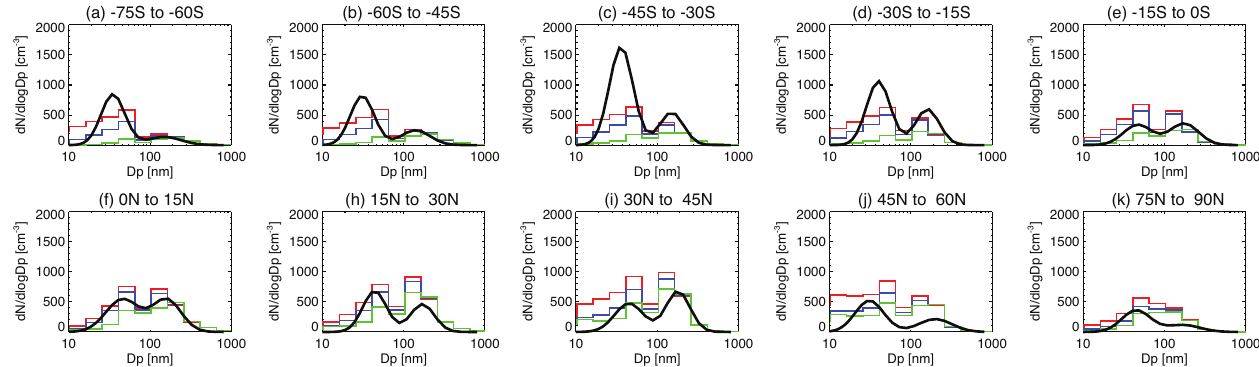
Figure 26. Annually and zonally averaged aerosol size distributions in the marine boundary layer. Observations are from Heintzenberg et al. (2000) and were compiled and aggregated into a 15 ◦ × 15 ◦ grid. The model is also averaged to the 15 ◦ grid and is shown as red lines for the BASE run, blue lines for the LowNUC run, and green lines for the NoNUC run.